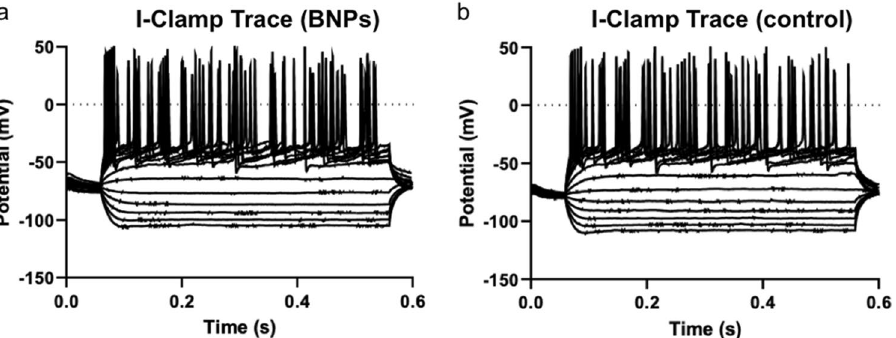
Figure 6. I-Clamp trace of neurons in the oxygen sensing nanoparticle treated slice ( a ) and the control slice ( b